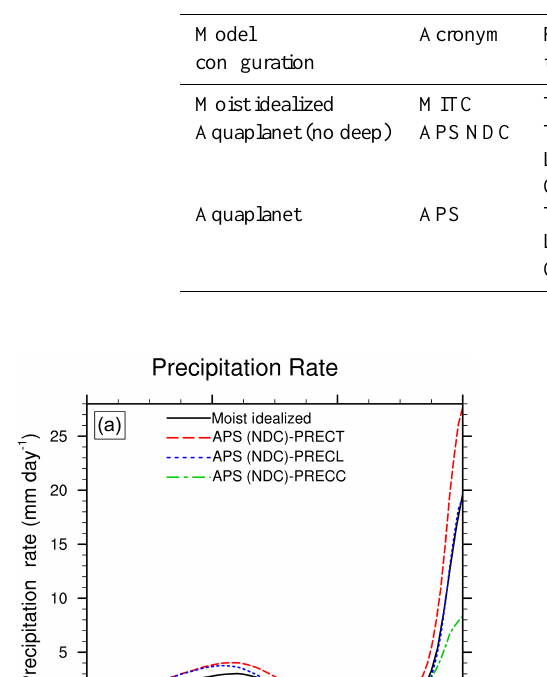
Table 2. Time-mean precipitation statistics for CAM5-SE in units mmday − 1 : global-mean and zonal-mean at the Equator showing the total precipitation rates (PRECT) and the fraction of large-scale (PRECL) vs. convective (PRECC) precipitation rates for MITC, APS NDC and APS.